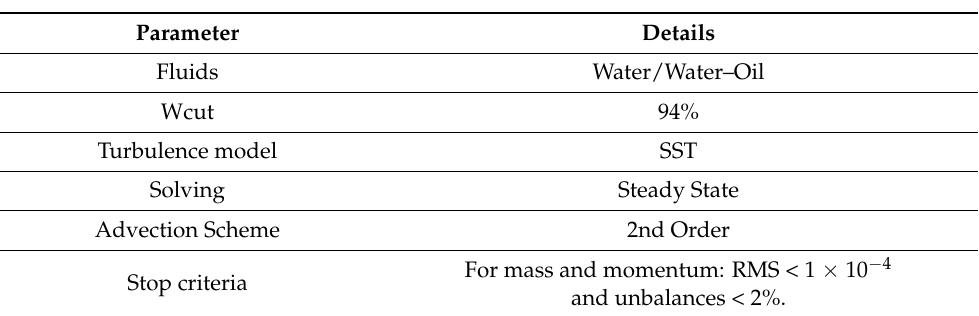
Table 2. Summary of simulation